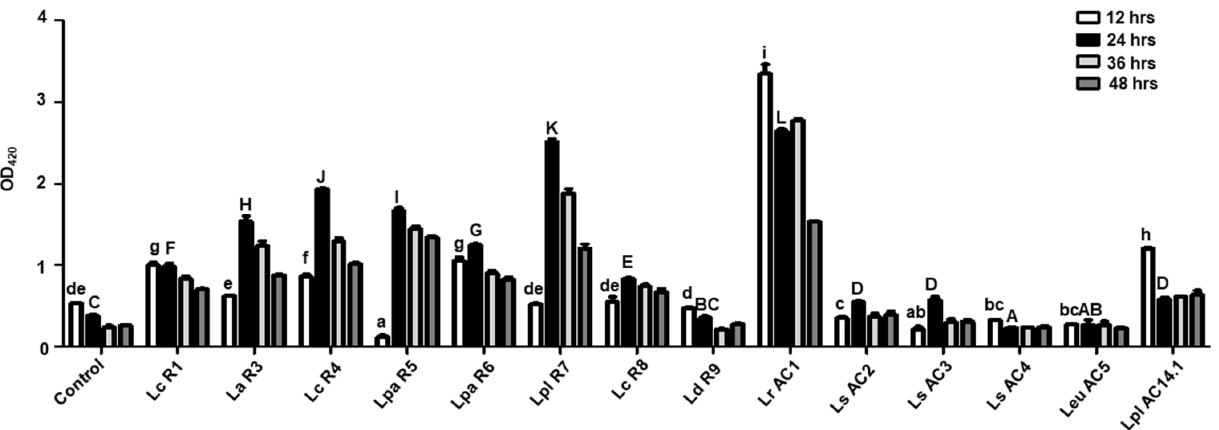
Figure 7. Potential hydrolytic capacity of β -glucosidase in the soymilk fermented by different LAB isolates. The results were compared by one-way ANOVA and Turkey post hoc test; p < 0.05; n = 2. Lower case letters represent the comparisons of results of groups after 12 h fermentation. Upper case letters represent the comparisons of results of groups after 24 h fermentation. Control: non-fermented soymilk. Lc, L. casei; La , L. acidophilus; Lpa , L. paracasei; Lpl , L. plantarum; Ld , L.